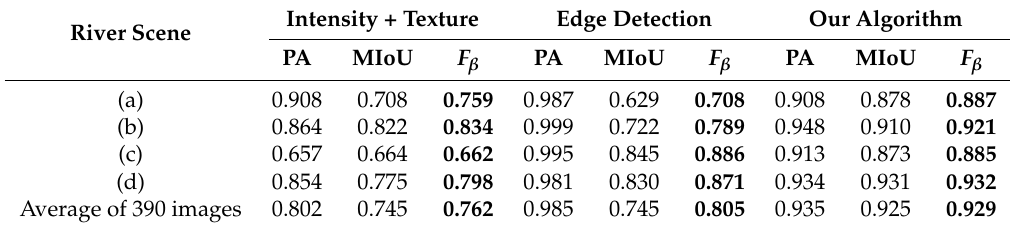
Table 2. Performance of different methods in complex